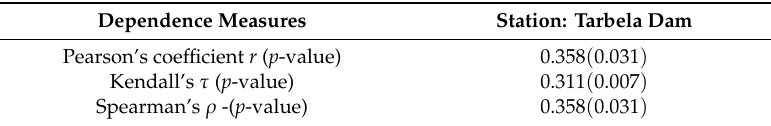
Table 3. Dependence measures of flood peak—volume.